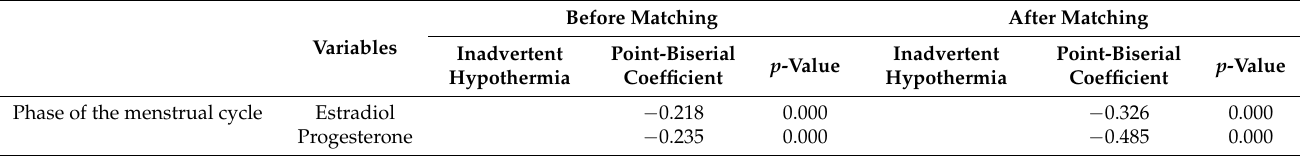
Table 3. Association of inadvertent intraoperative hypothermia with female reproductive hormones throughout the menstrual cycle.